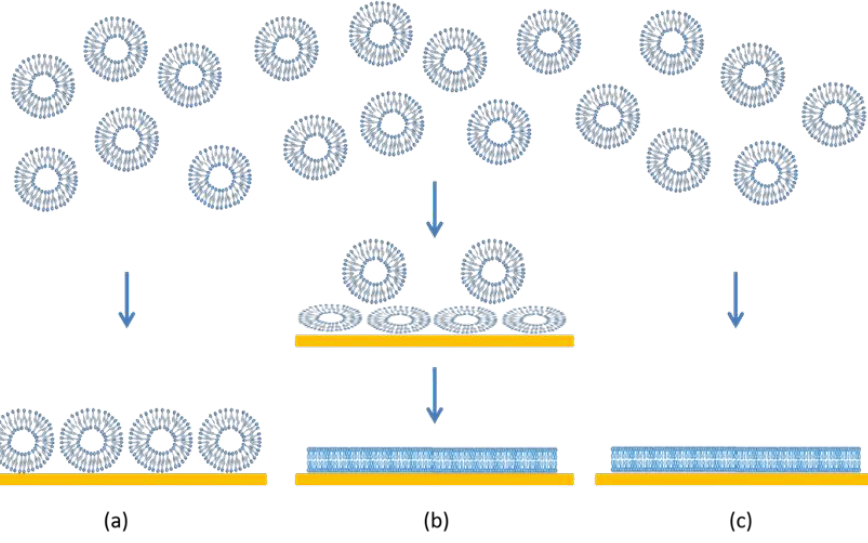
Figure 1. Characteristic scenarios of vesicle – quartz crystal interactions. ( a ) Vesicles adsorb on the surface but retain their shape and structure. No lipid bilayer is formed but a supported vesicle layer results. ( b ) Vesicles adsorb and consequently deform on the surface. In some cases, the vesicles can also fuse. At a critical surface concentration of vesicles, the deformed vesicles rupture to create planar lipid bilayer patches. The edges of the bilayer patch will promote rupturing of surrounding vesicles, resulting in a continuous supported lipid bilayer. ( c ) Vesicles break down immediately on contact with the surface to form planar bilayer patches and the bilayer patches merge to create a continuous planar bilayer.